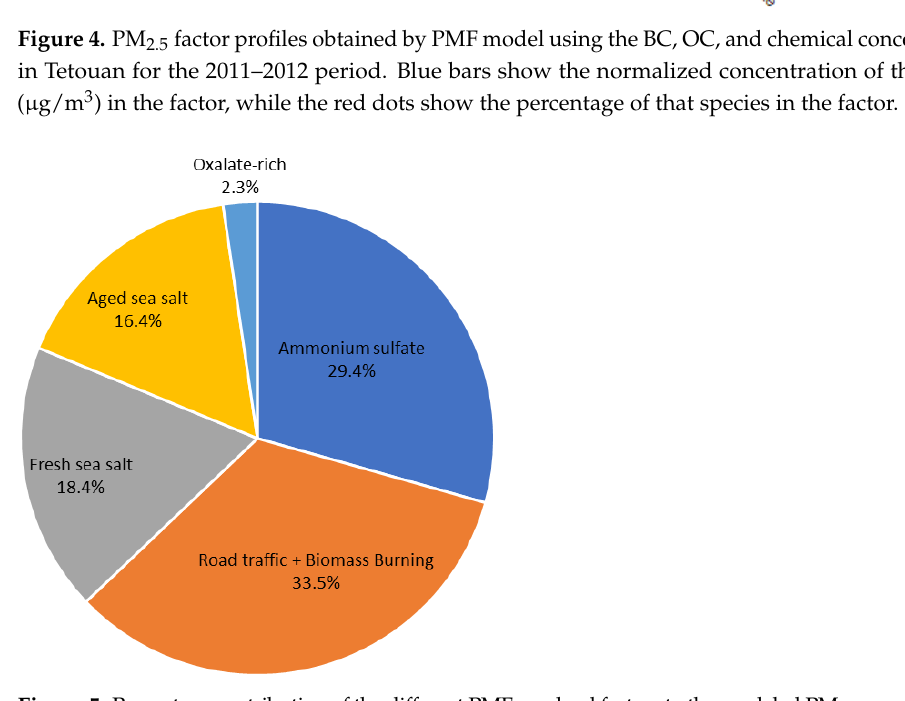
Figure 6. Seasonal contribution of the PMF-resolved sources to the PM 2.5 mass. Table 4. Summary of PMF-resolved sources and their specific tracers. Factor